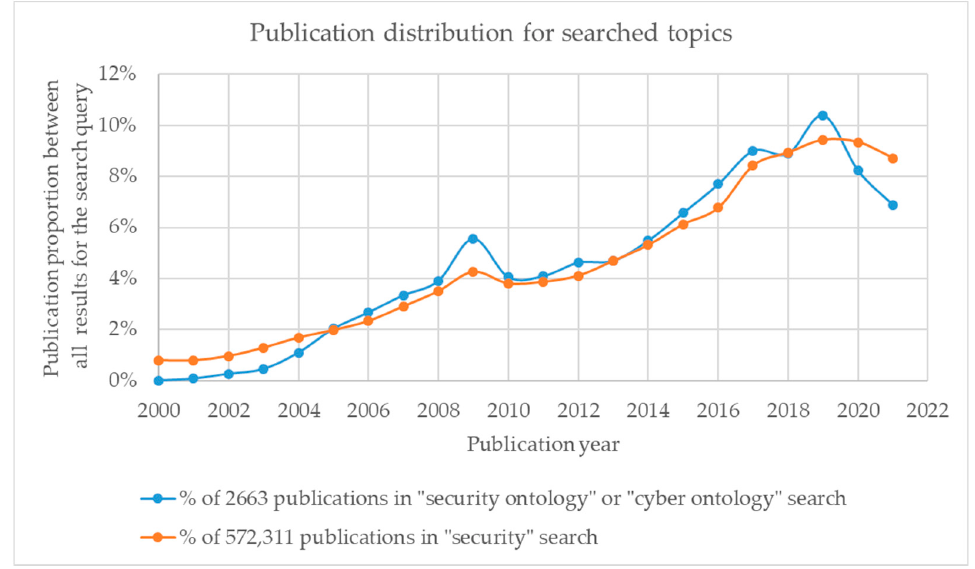
Figure 1. Growth of security ontology and security-related scientific papers.